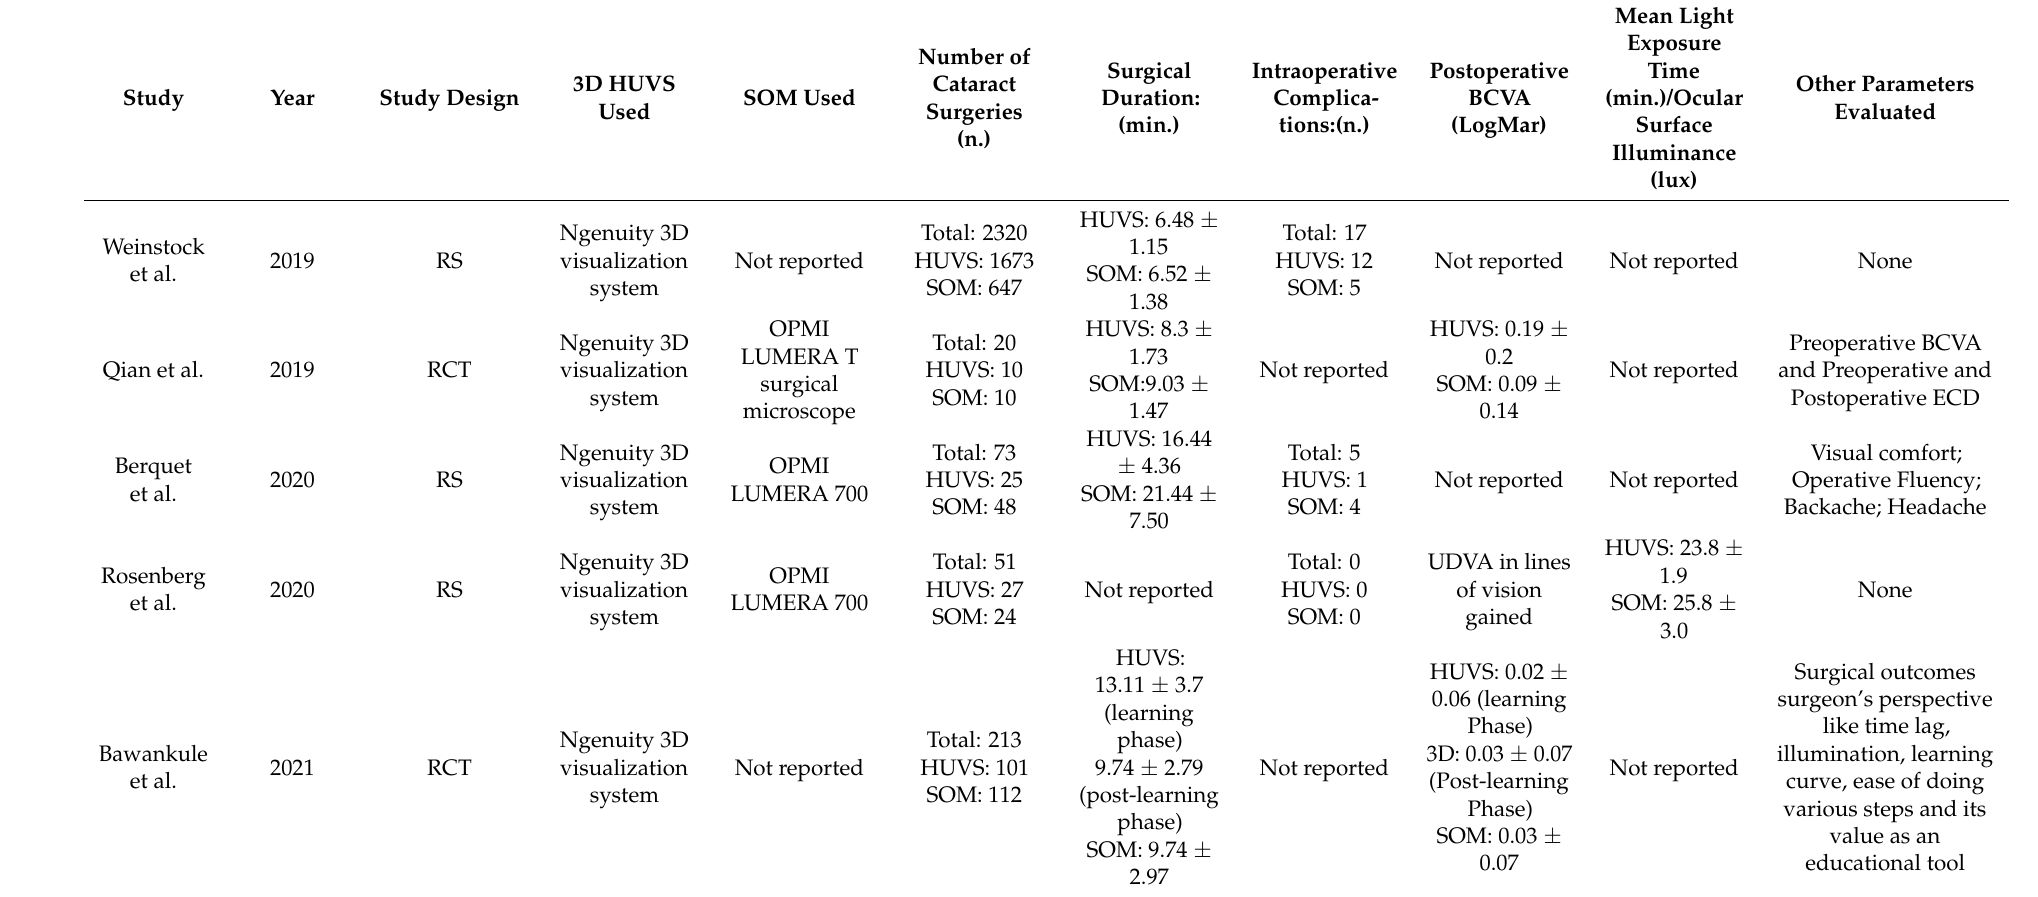
Table 1. Characteristics of studies included in the systematic review and